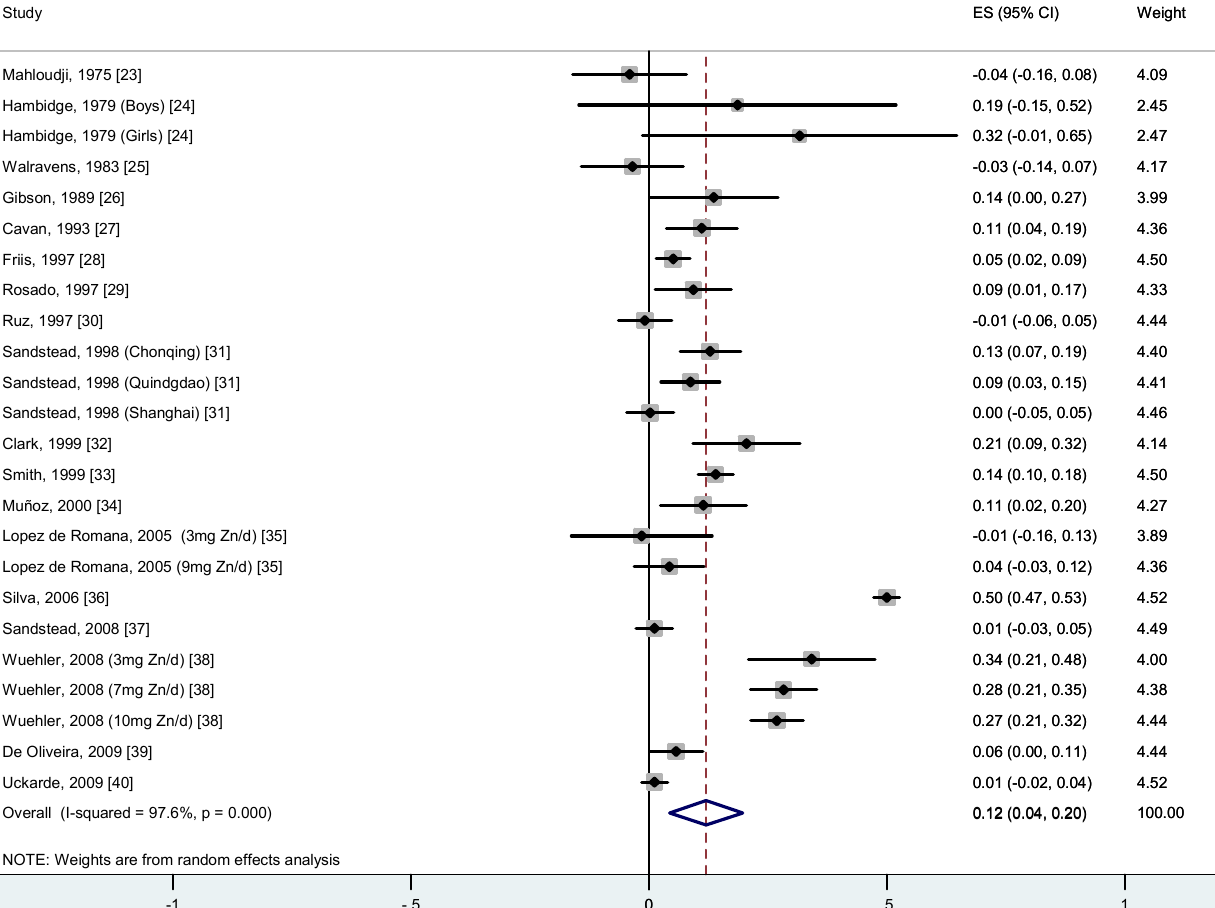
Figure 2. Random effects meta-analyses of RCTs evaluating the effect of dietary zinc on serum/plasma zinc in children. Beta’s represent the regression coefficients for the linear association between log transformed zinc intake and log transformed serum/plasma zinc e e status (lines represent the confidence intervals of each